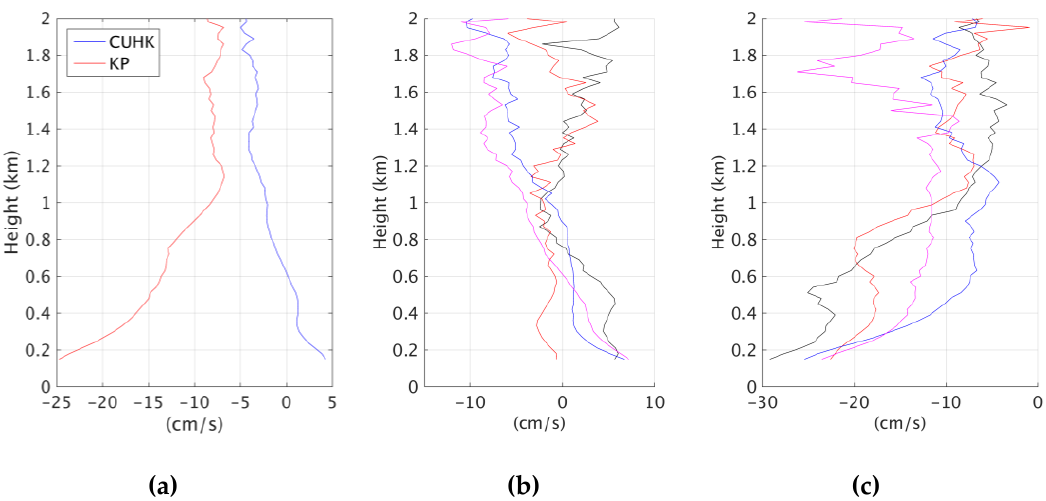
Figure 9. ( a ) Annual vertical profiles of vertical wind velocity (cm / s) at CUHK (blue) and KP (red) and seasonal vertical profiles at CUHK ( b ) and KP ( c ) during spring (black), summer (red), fall (blue), and winter (magenta). Positive values refer to upward motions; whereas negative values refer to download motions.